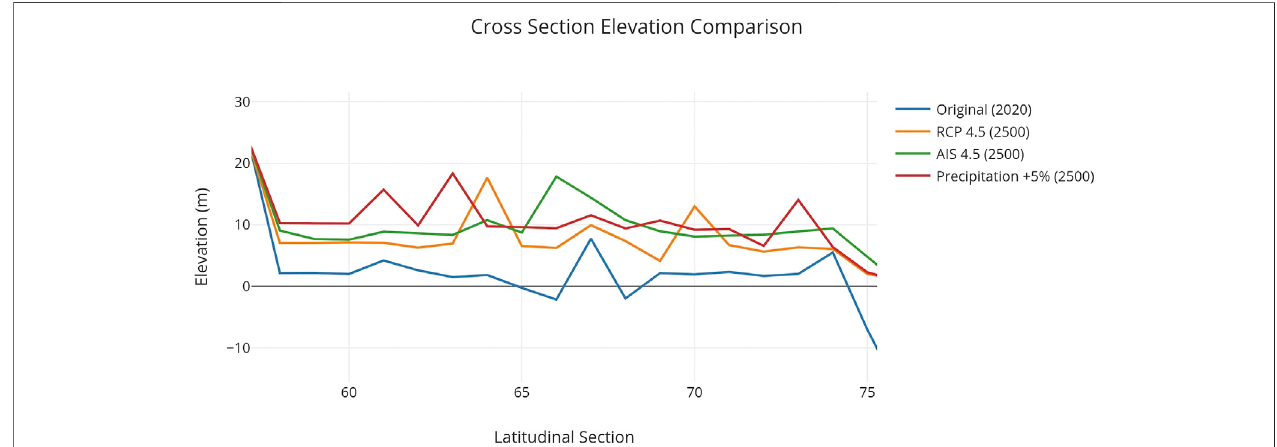
FIGURE 13 | Comparison of the elevation differences between a few scenarios in a cross section of the fl oodplain region (by 2500), demonstrating the drastic control future climate change scenarios.